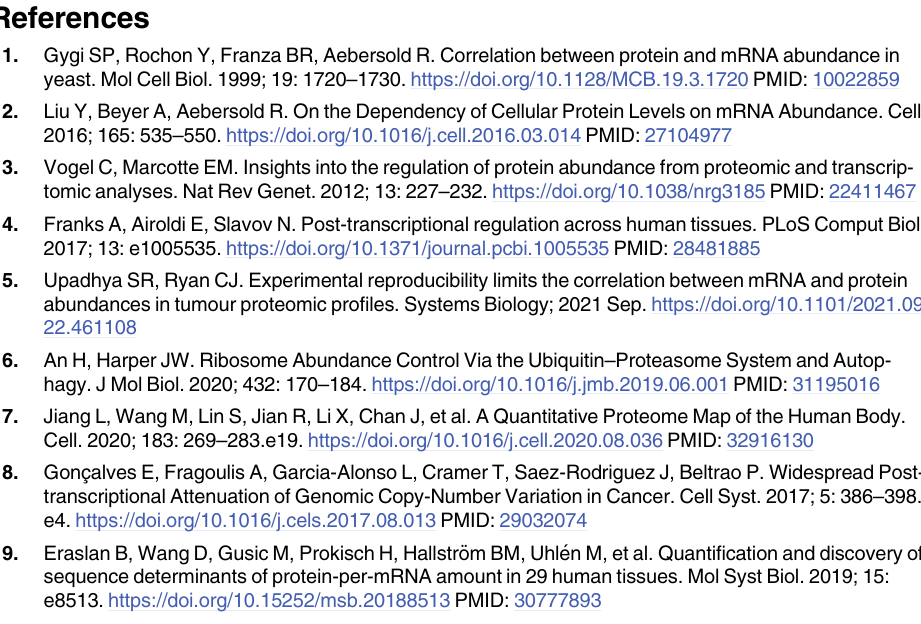
S6 Table. Network edge list for proteins with improved predictions in the CORUM feature set along with the coefficients and feature importances of contributing transcripts. S7 Table. Network edge list for proteins with improved predictions in the STRING feature set along with the coefficients and feature importances of contributing transcripts. S8 Table. Hub genes based on centrality scores in the STRING feature set